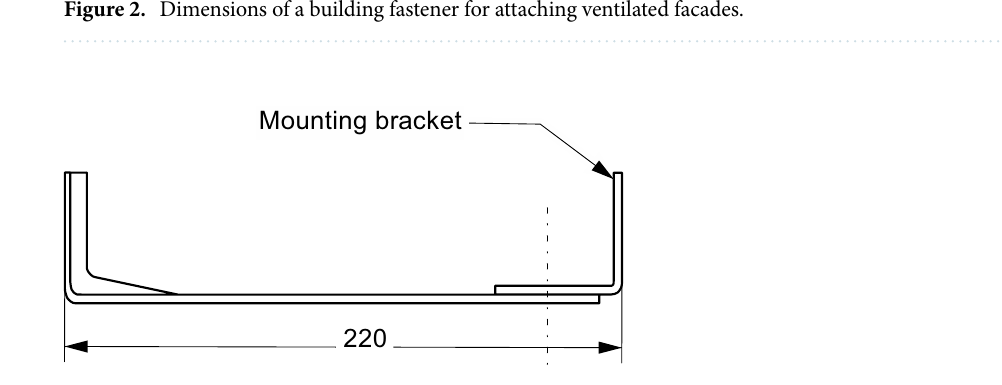
Figure 3. Building fastener with mounting